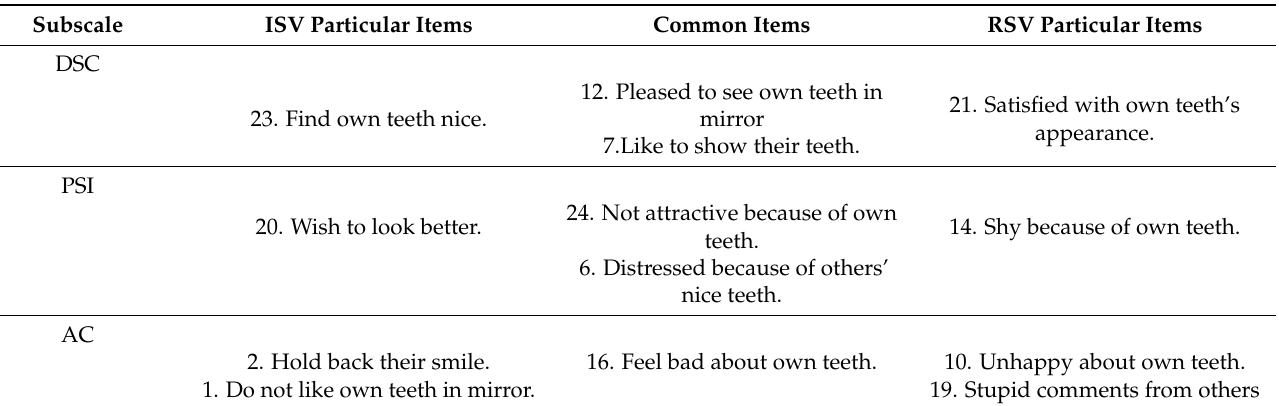
Table 3. Items of PIDAQ(A)-ISV9 and